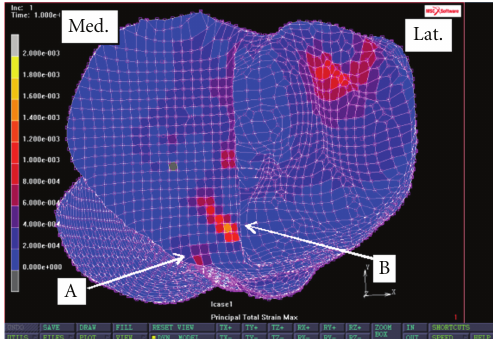
Figure 5: Maximum principal strain at implant-bone interface of a medial PKR knee with no external fixations. “A” indicates the first region with high tensile strain. “B” indicates the second region with high tensile strain.